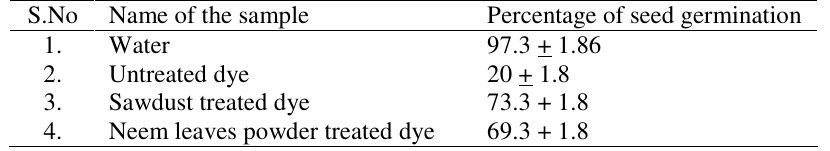
Table 2. The effect of adsorbent dosage on percentage of seed germination of Vigna mungo L.